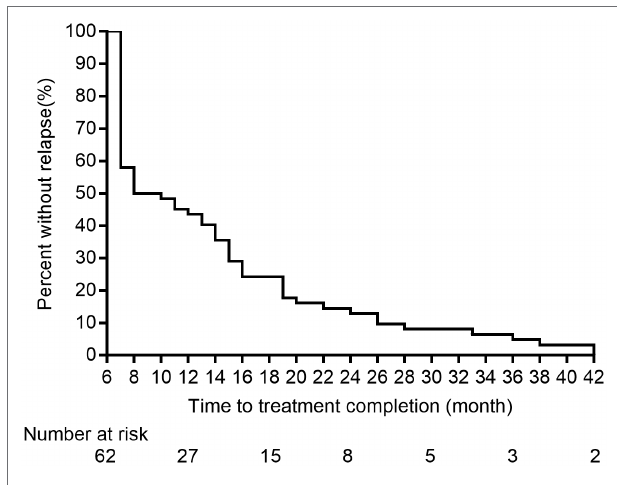
FIGURE 3 | The correlation between recurrence time and recurrence ratio of the enrolled TB